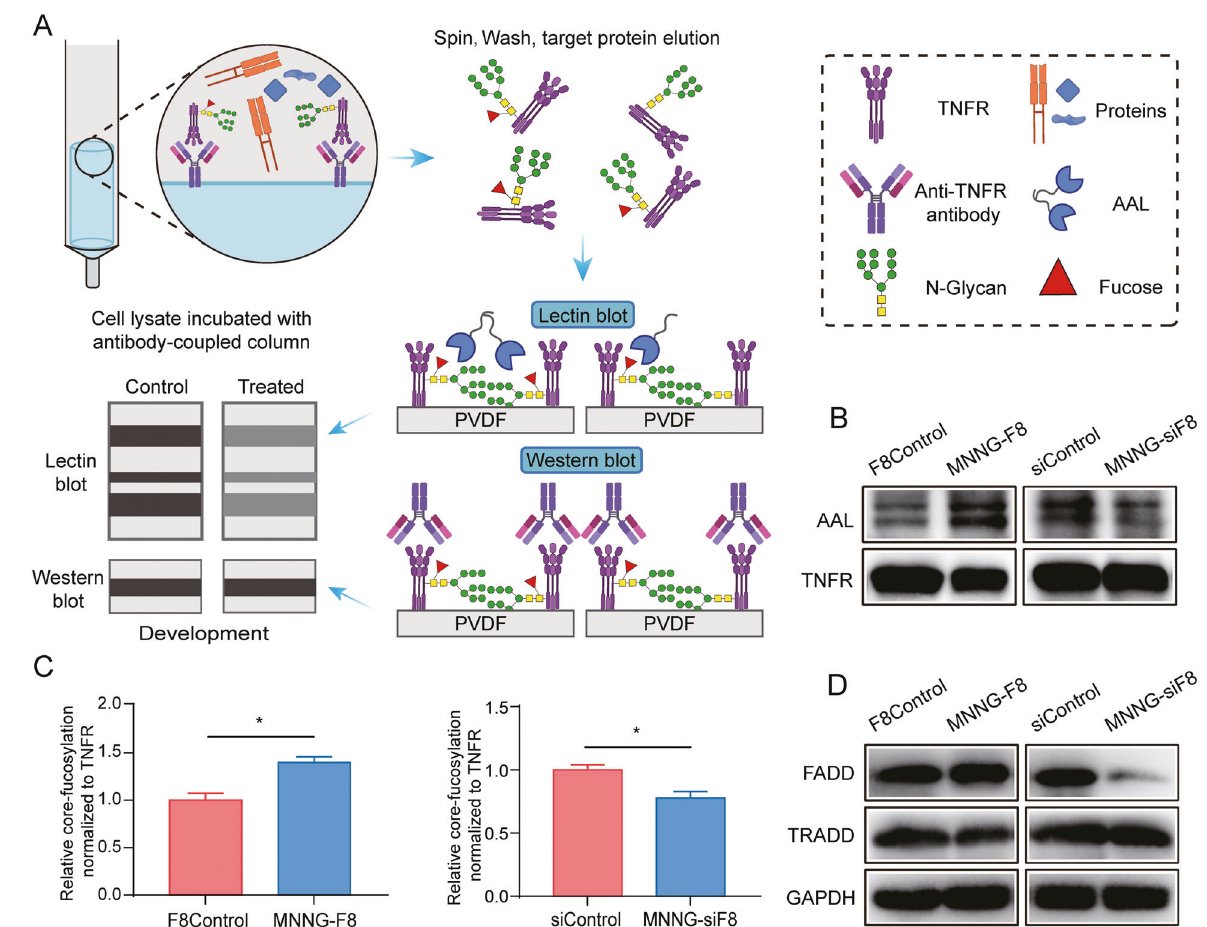
Fig. 7 Lack of core fucosylation of TNFR shifts TNF signaling. A Diagram illustrating the method for detecting core-fucosylation level of TNFR in FUT8 regulated cells and their according control cells. TNFR was fi rst enriched from the four cell strains by immunoprecipitation using an anti-TNFR antibody. Then, Western blot and lectin blot, respectively, were used to detect expression of TNFR and core-fucosylation level of TNFR. The lectin blot was done using the AAL, which speci fi cally identi fi es a combination of core-fucosylated structures. Relative expression of core fucosylation was normalized to TNFR expression. B Western blot of TNFR and lectin blot of core fucosylation of TNFR. Core fucosylation per unit TNFR was increased in MNNG-F8 but reduced in MNNG-siF8 cells compared to control cells. C Quantitation of core-fucosylation levels ( N = 3). D Western blot analysis of the shifts TNF signaling. The TNFR down-stream adaptor molecules that mediates cell apoptotic FADD and TRADD were detected by Western blot. The expression of FADD was obvious changed after altering FUT8 levels, while that of TRADD did not change. Relative expression of proteins was normalized to GAPDH. * P <